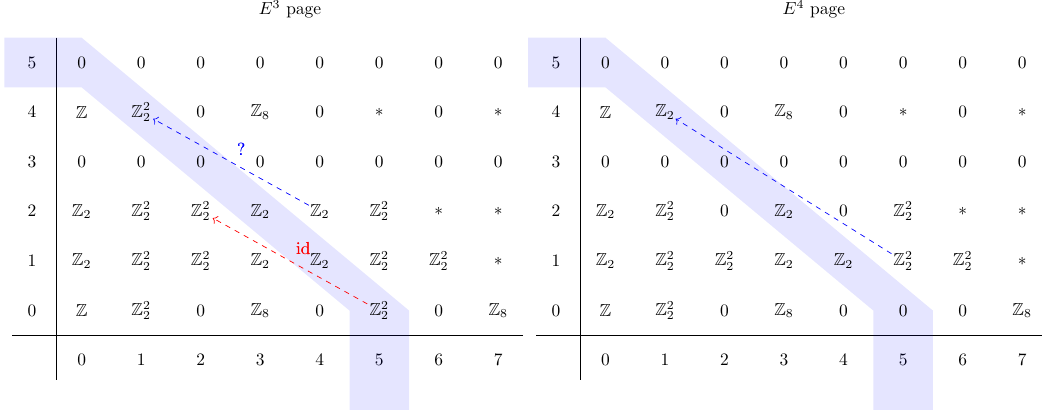
Figure 7. The E 2 page of the AHSS for calculating Ω Spin • ( BQ 8 ) . E 3 page